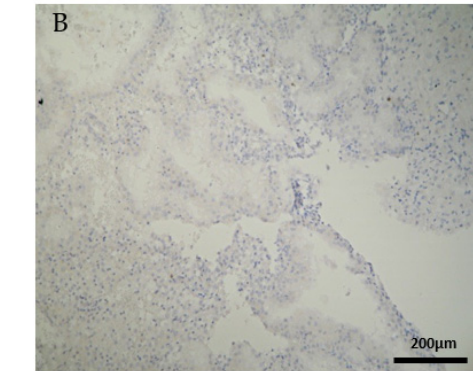
Figure 6 . Evaluation of positive CD8 antigen expression. Control group (CG): ( Α ) Negative CD8 Figure 6. Evaluation of positive CD8 antigen expression. Control group (CG): ( A ) Negative CD8 expression in the decidua parietalis (4 × 4 magnification). ( Β ) Almost negative CD8 expression in expression in the decidua parietalis (4 × 4 magnification). ( B ) Almost negative CD8 expression in the the chorionic villi (trophoblast) (4 × 4 magnification). chorionic villi (trophoblast) (4 × 4 magnification).